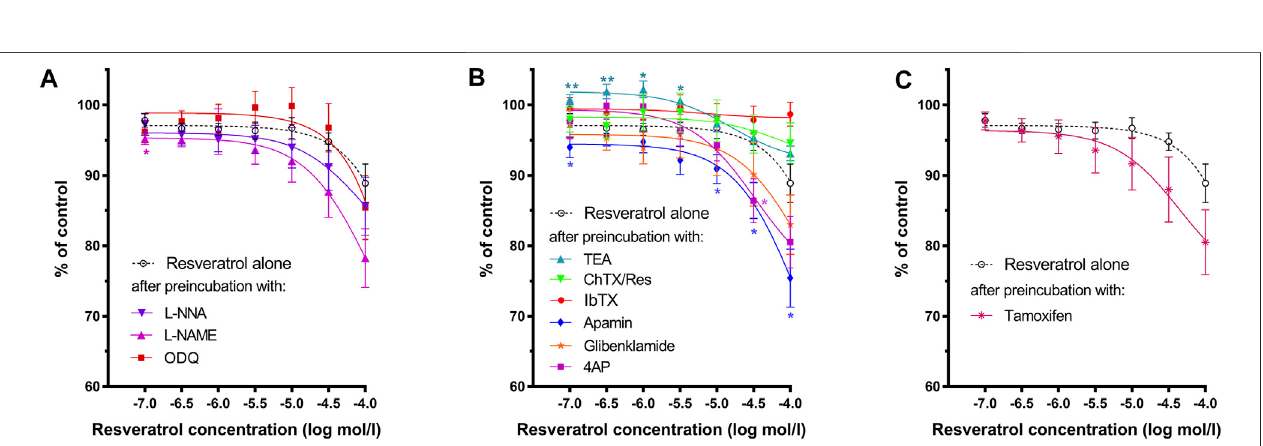
FIGURE 4 | Effects of resveratrol on the basal tension of gastric muscle samples after preincubation with (A) — L-NNA, L-NAME, ODQ; (B) — TEA, IbTX, ChTX, apamin glibenclamide or 4AP; (C) — tamoxifen. Each point represents the mean ± SEM of basal tension values obtained from individual strips ( n (cid:1) 10) from different patients. Basal tension of carbachol-induced contractions of each gastric strip over a 10-min interval before the addition of the antagonist was treated as control. Signi fi cance at * p < 0.05; ** p < 0.01 as compared to the basal tension of resveratrol alone.